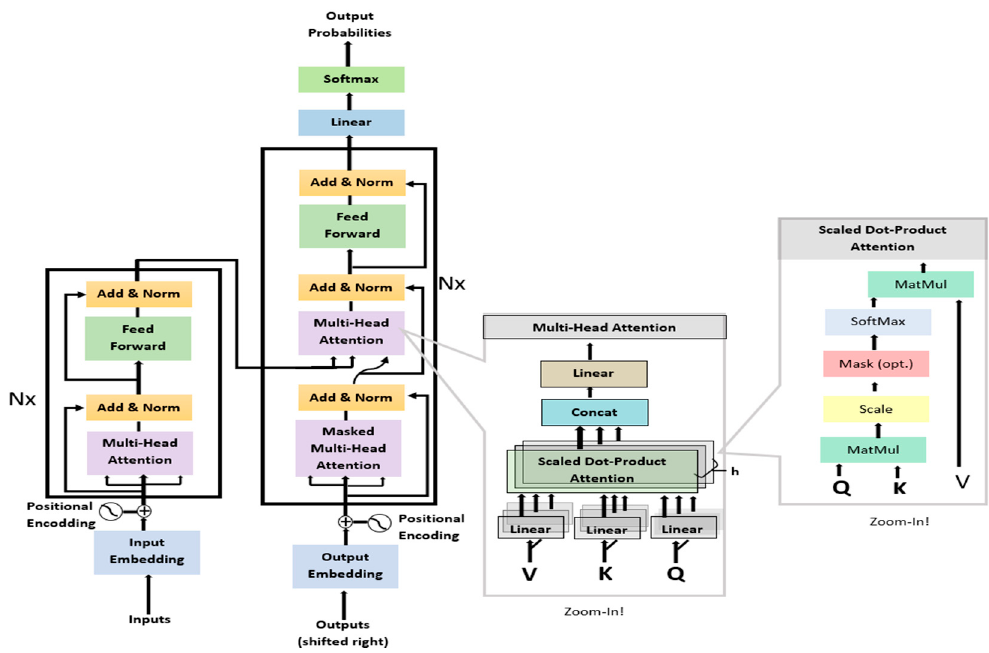
Figure 4. Transformer architecture.